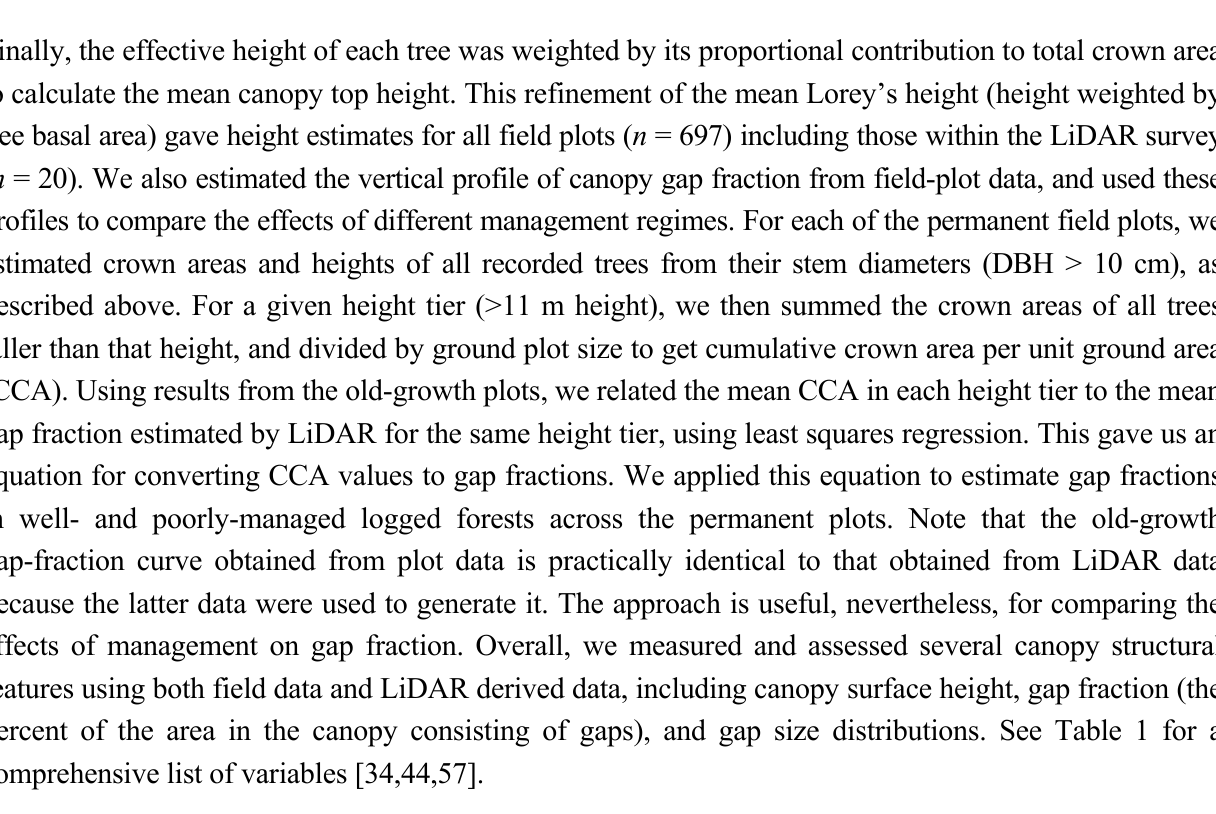
Table 1. A list of canopy structure variables used in the study, including field- and LiDAR-based estimates of canopy height and gap